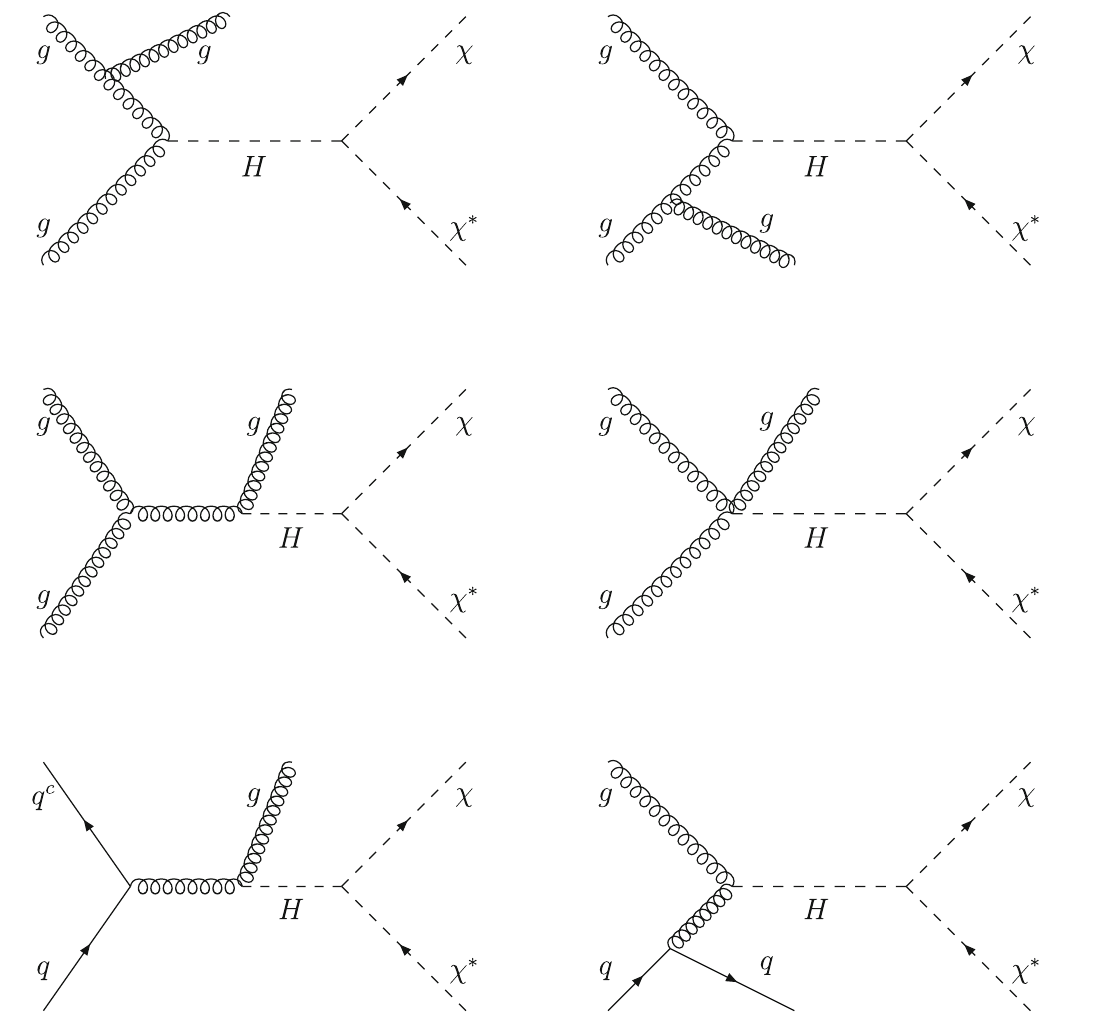
Fig. 3 Monojet production at the LHC associated with the emission of a dark matter pair